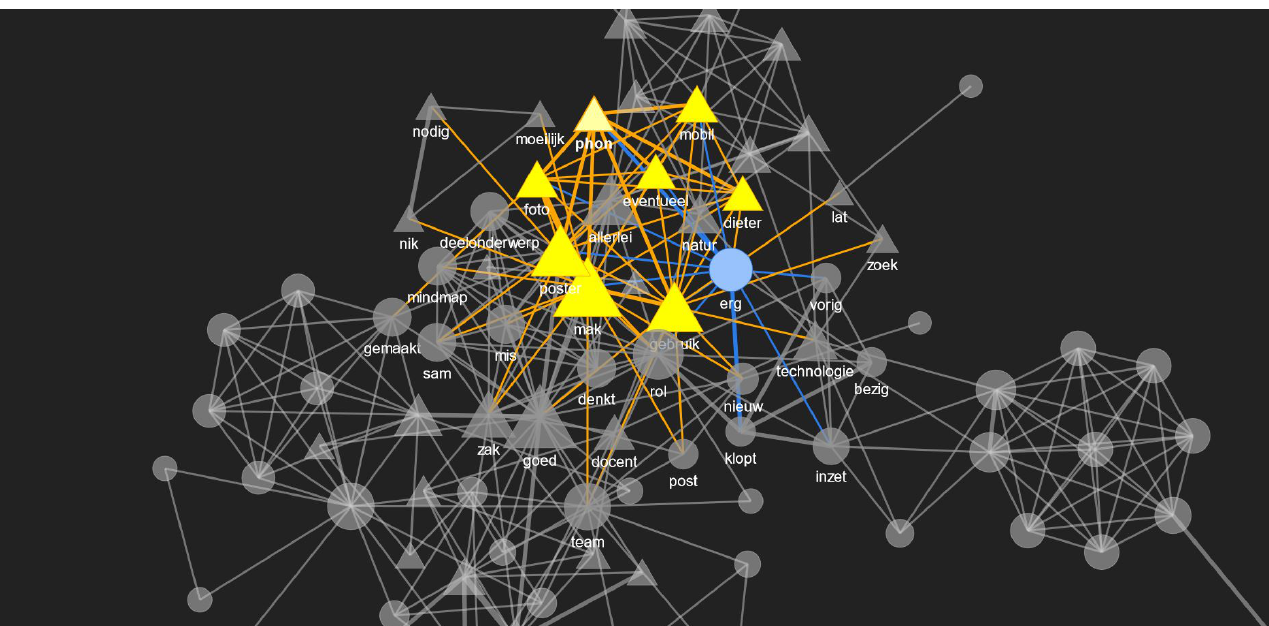
Figure 12. A sample social network (or network graph) of the words of the TEL LA advisor (shown as rectangles in yellow when highlighted) along with the whole red phase conversation (all other roles are shown as circles in blue when highlighted).